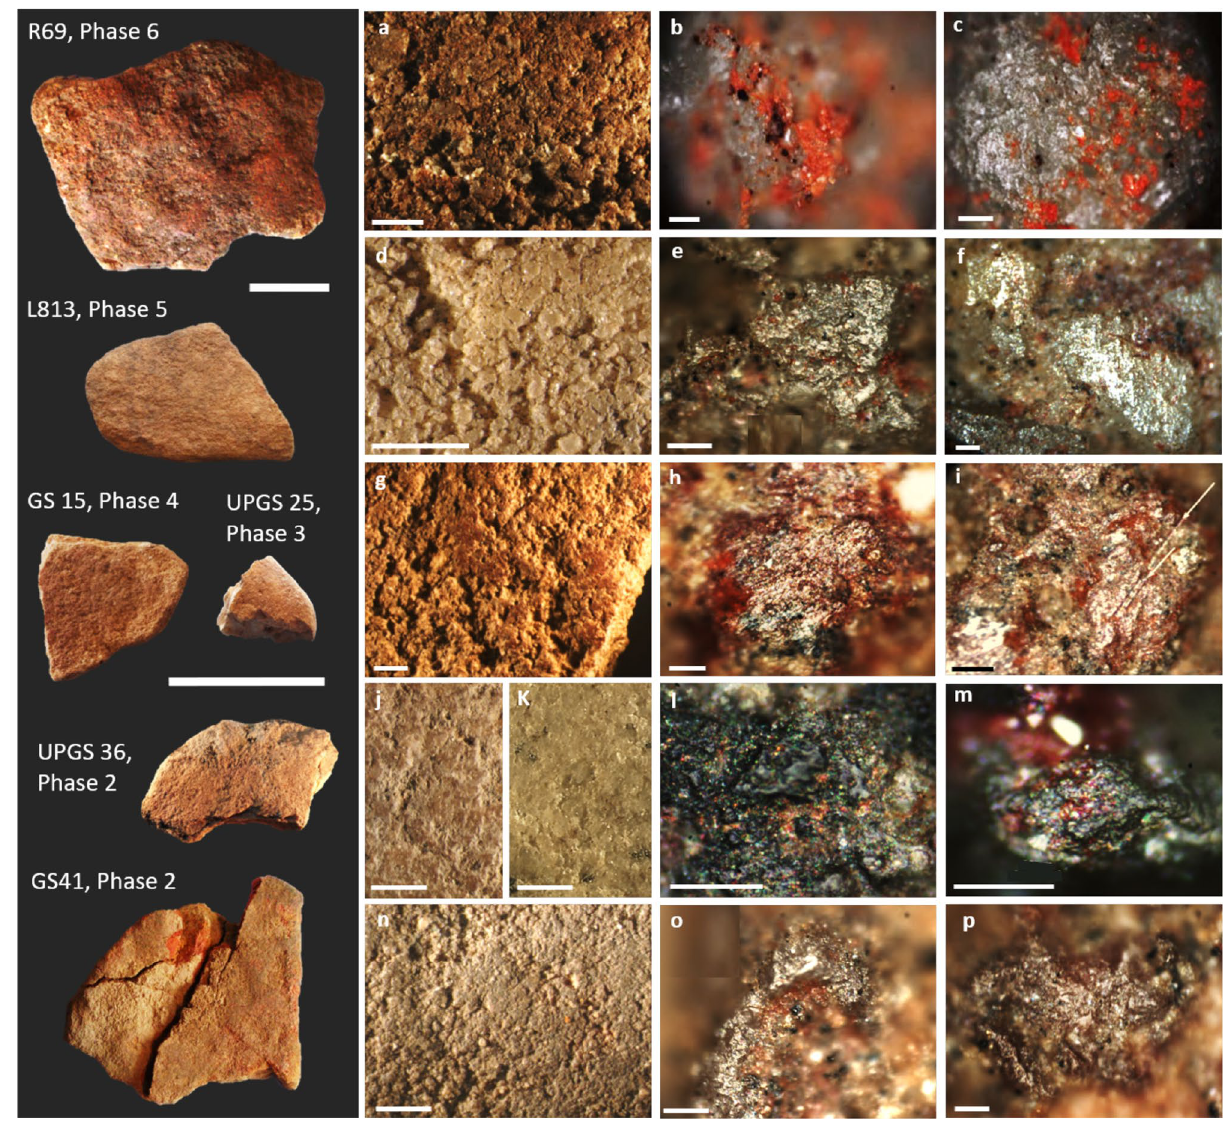
Figure 5. Examples of grinding stones from Madjedbebe with usewear and residues consistent with processing red pigment. Note that the red mineral grains occur in the lower recesses of the stone micro-topography and occur with an undulating use-polish. ( a – c ) Usewear and red pigment residues on R66 from Phase 6; ( d – f ) usewear and red pigment residues on L813 from Phase 5; ( g – i ) usewear and red pigment residues on GS15 from Phase 4; ( j , l ) usewear and red pigment residues on UPGS25 from Phase 3; ( k , m ) usewear and red pigment residues on UPGS36 from Phase 2; ( n – p ) usewear and red pigment residues on GS41 from Phase 2. Scale bars for artefact images are 5 cm; scale bars for low magnification images are 2 mm; scale bars for high magnification images are 0.05